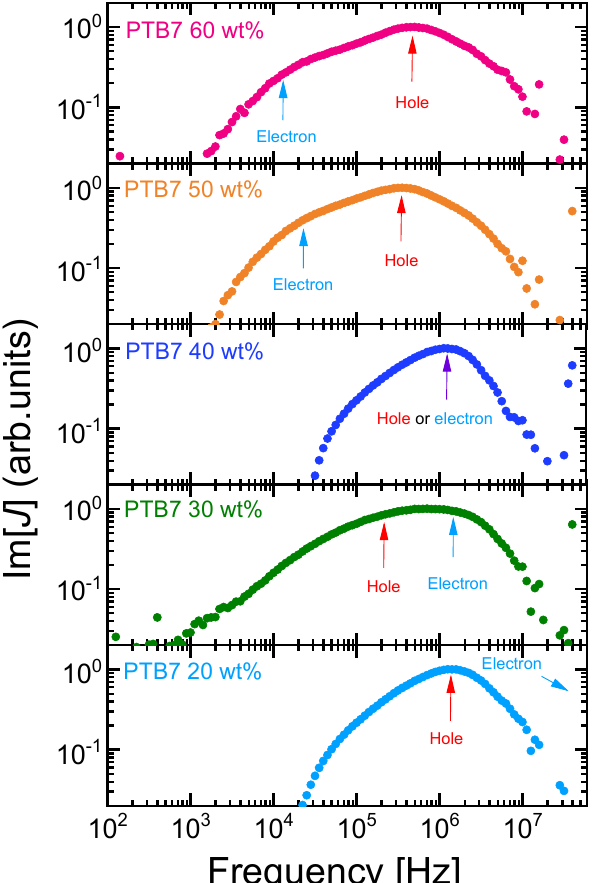
Figure 7. Imaginary part of MPC spectra of PTB7:PC 71 BM inverted OPVs with different PTB7 content under short-circuit conditions. Arrows highlight frequencies at structures due to electron and hole transit. Structure due to electron transit in 20 wt% PTB7:PC 71 BM OPV is not observed and may be located at a higher frequency (>10 MHz).